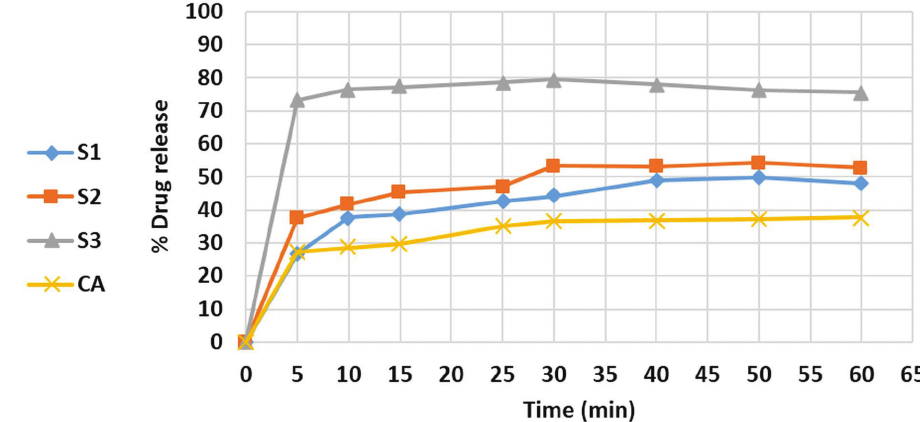
FIGURE 3 - In vitro dissolution profiles of cefuroxime axetil and solid dispersions prepared by solvent method.